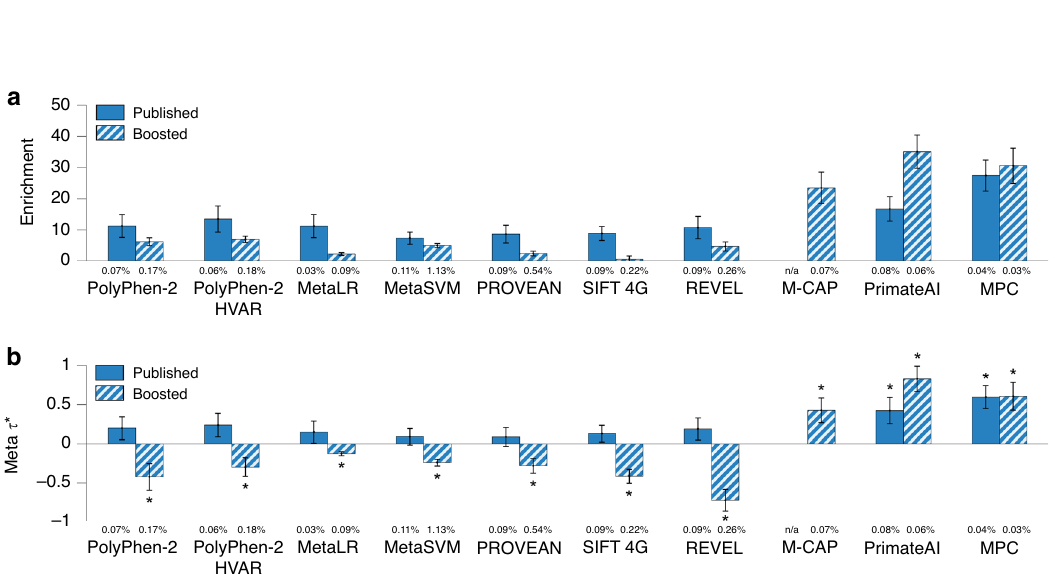
Fig. 1 Informativeness for a common disease of binary annotations derived from 11 Mendelian disease-derived missense scores and corresponding boosted scores. We report ( a ) heritability enrichment of binary annotations derived from published and boosted Mendelian disease-derived missense scores, meta-analyzed across 41 independent traits; b conditional τ * values, conditioning on the baseline-LD model (for annotations derived from published scores) or the baseline-LD model and corresponding published annotations (for annotations derived from boosted scores). We report results for 10 Mendelian disease-derived missense scores (of 11 analyzed) for which annotations derived from published and/or boosted scores were conditionally signi fi cant; the published M-CAP score spanned too few SNPs to be included in the S-LDSC analysis. The percentage under each bar denotes the proportion of SNPs in the annotation; the proportion of top SNPs included in each annotation was optimized to maximize informativeness (largest ∣ τ * ∣ among Bonferroni-signi fi cant annotations, or most signi fi cant p -value if no annotation was Bonferroni-signi fi cant). Error bars denote 95% con fi dence intervals. In ( b ), * denotes conditionally signi fi cant annotations. Numerical results are reported in Supplementary Data 1. Results for standardized enrichment, de fi ned as enrichment times the standard deviation of annotation value (to adjust for annotation size), are reported in Supplementary Data